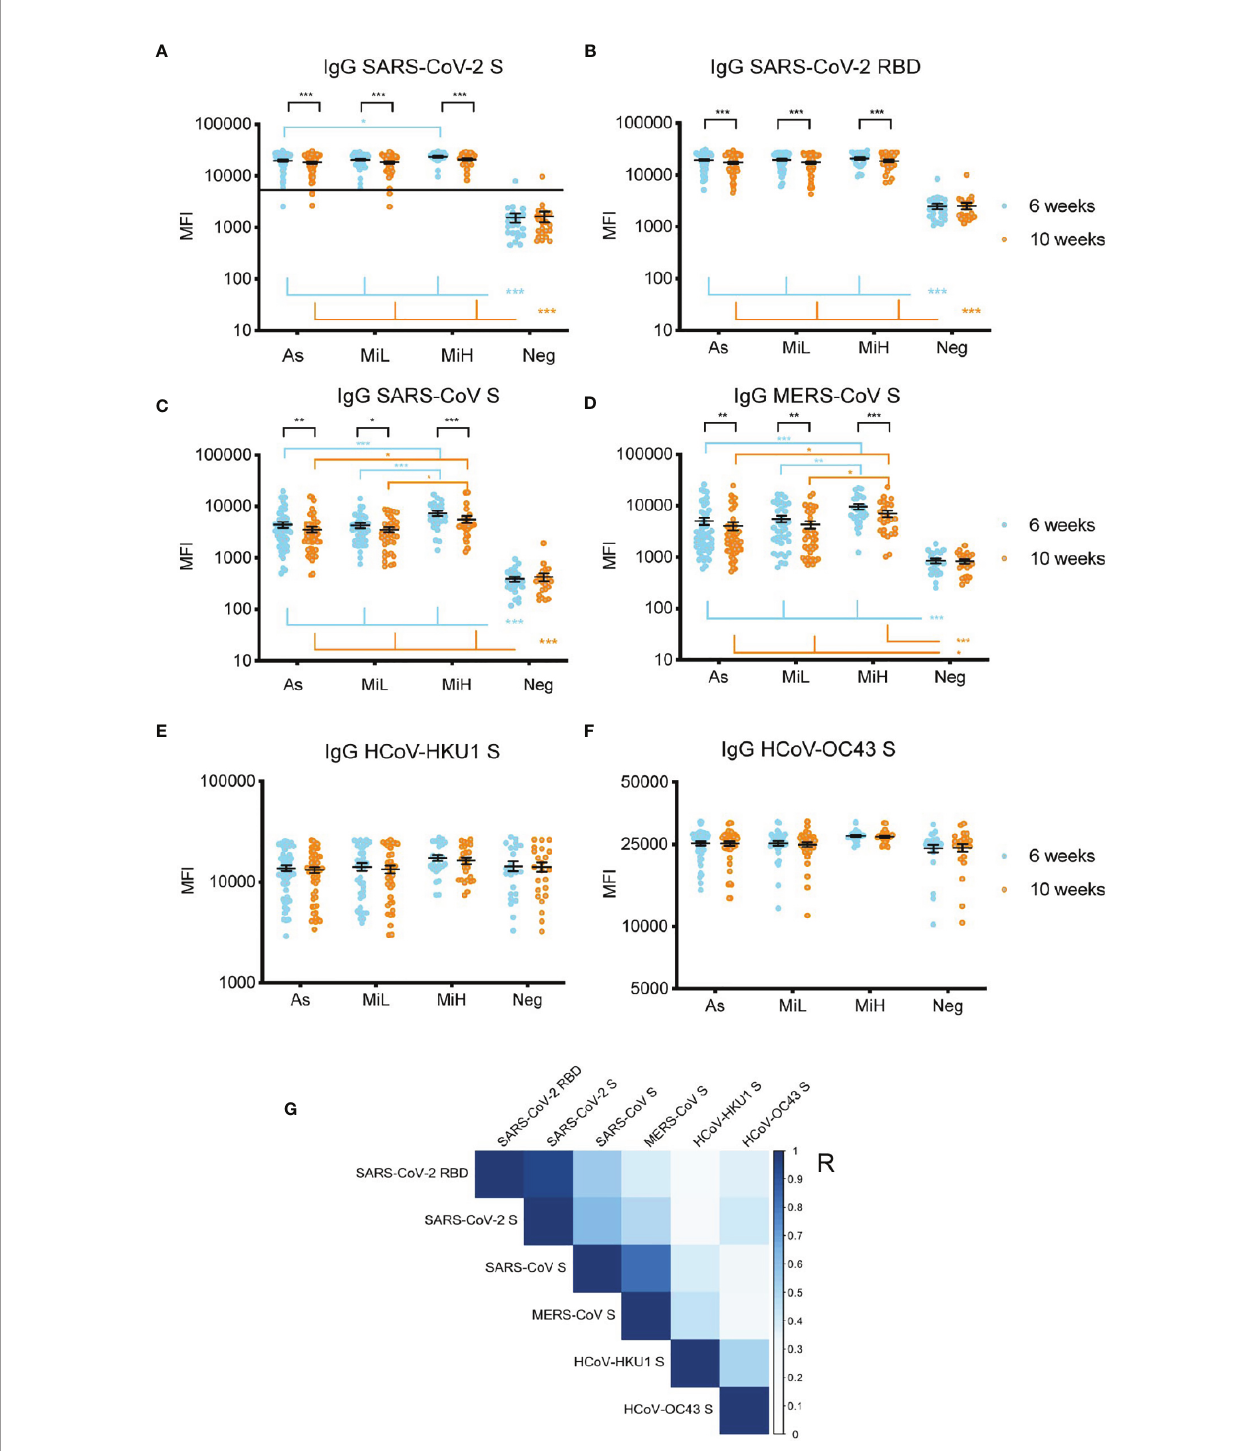
FIGURE 3 | IgG serum reactivity against the RBD and S protein of SARS-CoV-2 (A, B) and S from other beta-coronaviruses using an MMIA (C – F) and correlation analysis (G) in samples from 136 participants (As n=52 [6 female, 46 male]; MiL n= 36 [11 female, 25 male]; MiH n= 25 [11 female, 14 male). Continuous line in (A) indicate the threshold of positivity for SARS-CoV-2 S protein (19, 22). Two-way ANOVA test followed by multiple comparisons with Benjamini-Hochberg method (desired FDR 0.05). Adjusted p-values *< 0.05; **< 0.01; ***< 0.001. (G) Pearson correlation of IgG reactivity among SARS-CoV-2 RBD, SARS-CoV S, MERS-CoV S, HCoV-HKU1 S and HCoV-OC43 S. R, correlation coef fi